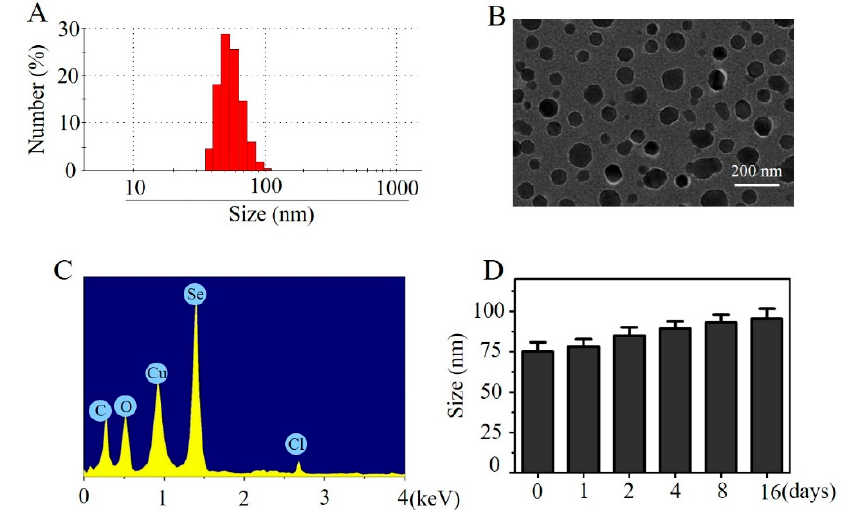
Figure 1. Characterization of FA-Se@DOX nanoparticles. ( A ) Particle size distribution of FA-Se@DOX